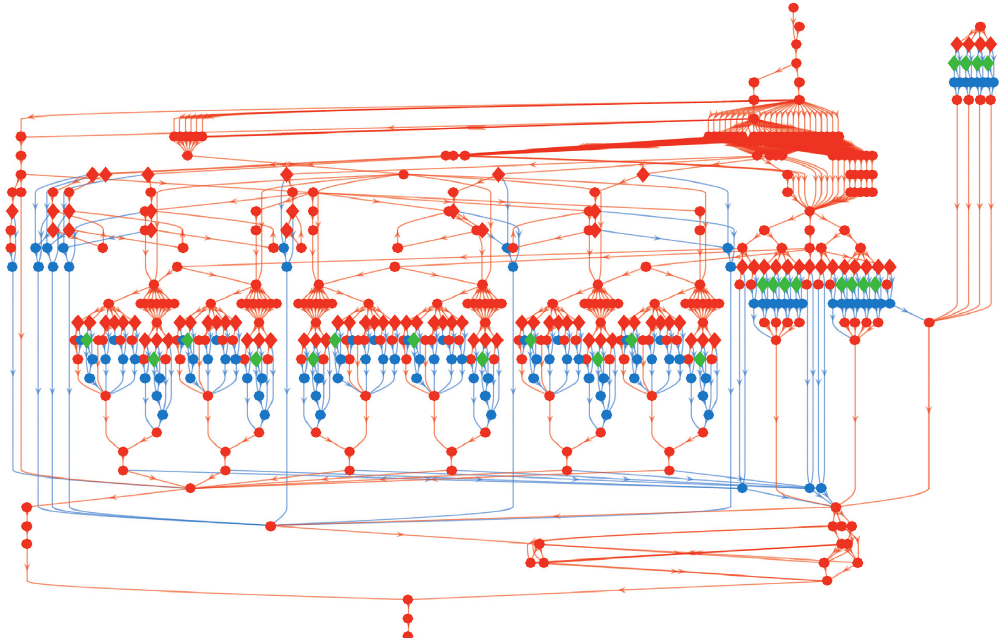
Figure 8: The shortest path of a network of 10 nodes and 15